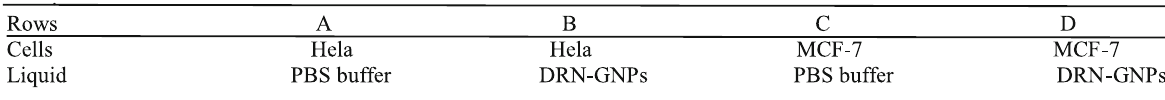
Fig. 4 The contents of the rows are listed as follows: